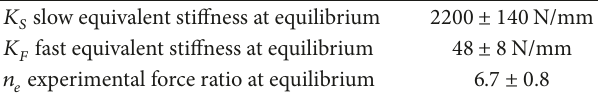
Table 1: 𝑍 -transmitter slow and fast stages stiffness at 15 ∘